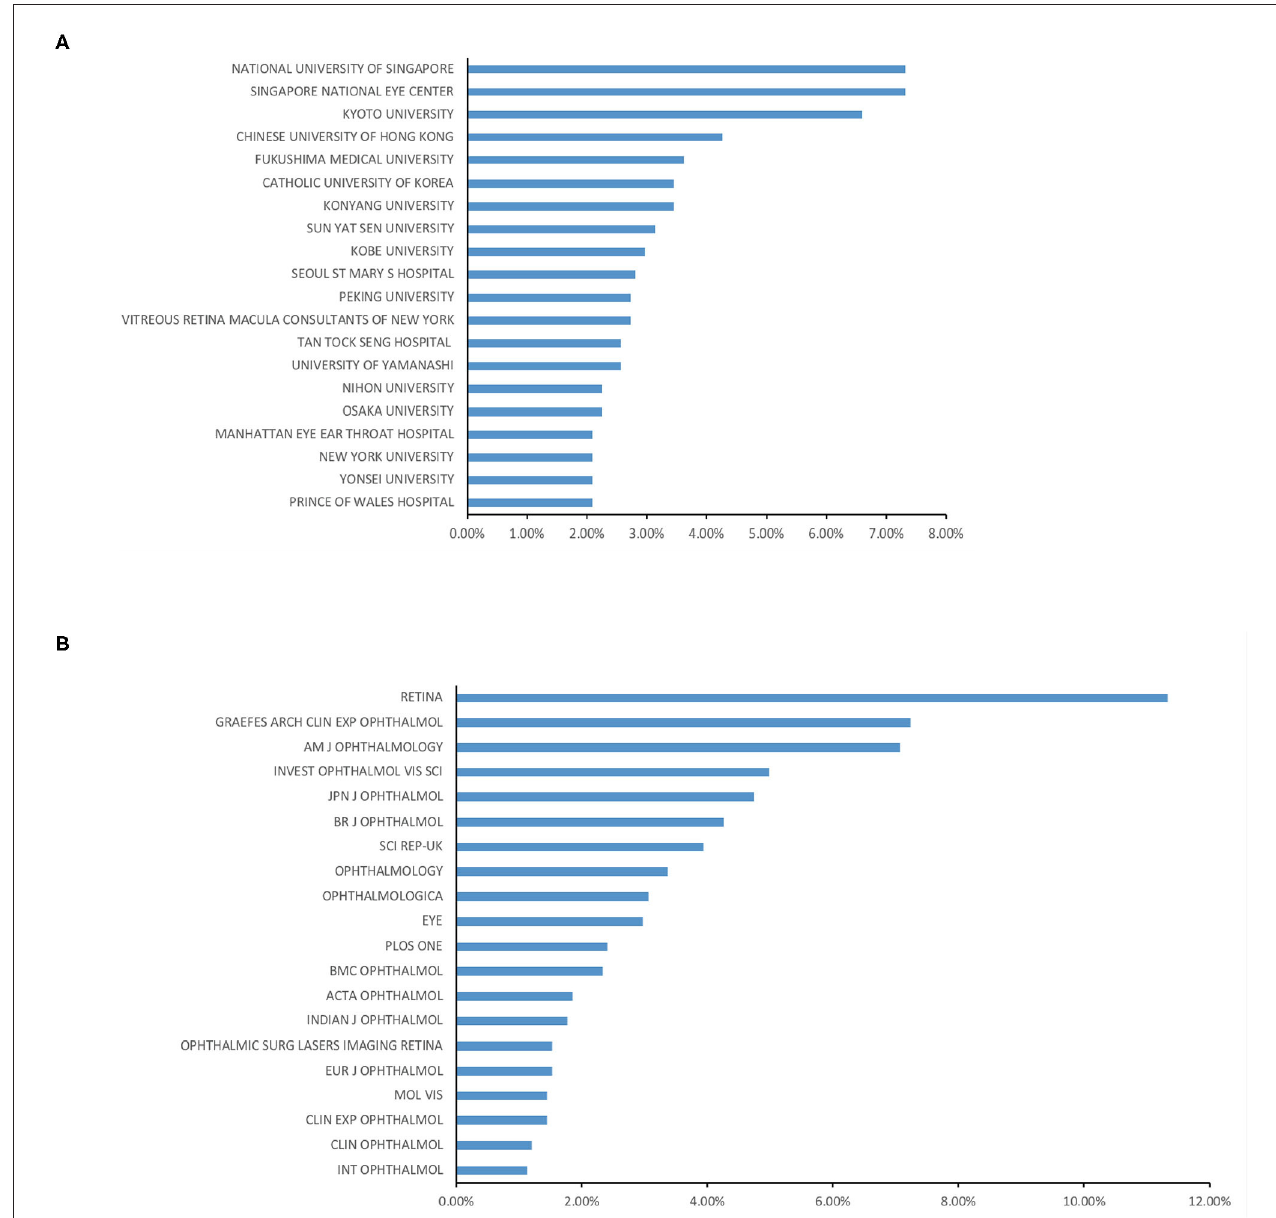
FIGURE 3 | (A) Top 20 institutions all over the world ranked by the publication numbers. (B) Top 20 journals published most in this field.